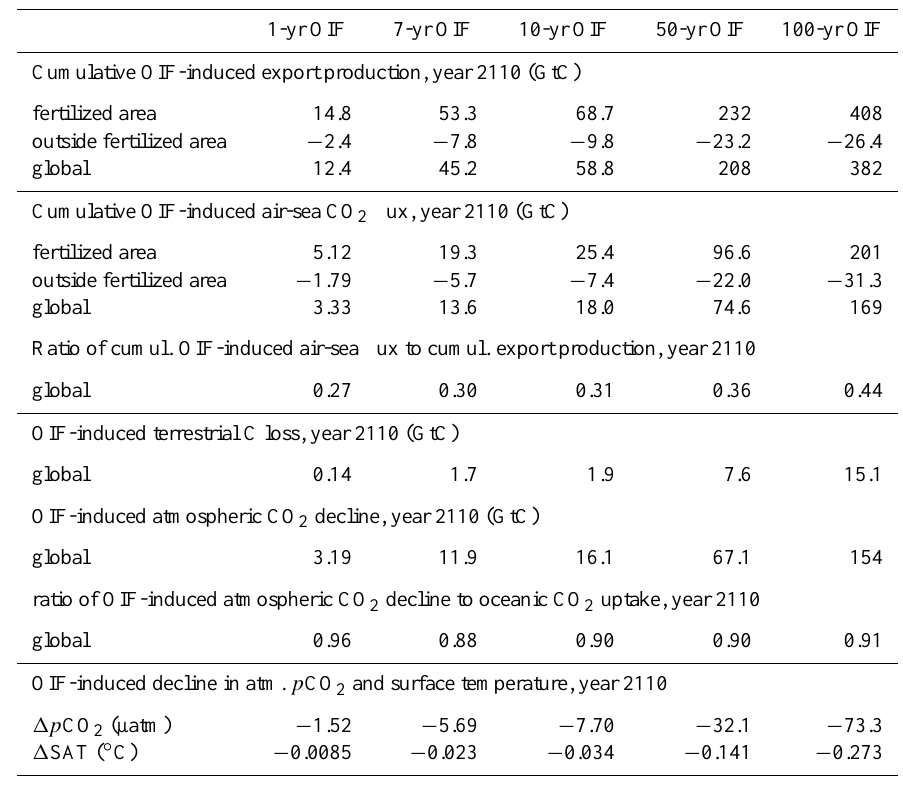
Table A1. Model results for µ max =10day − 1 sensitivity experiment.